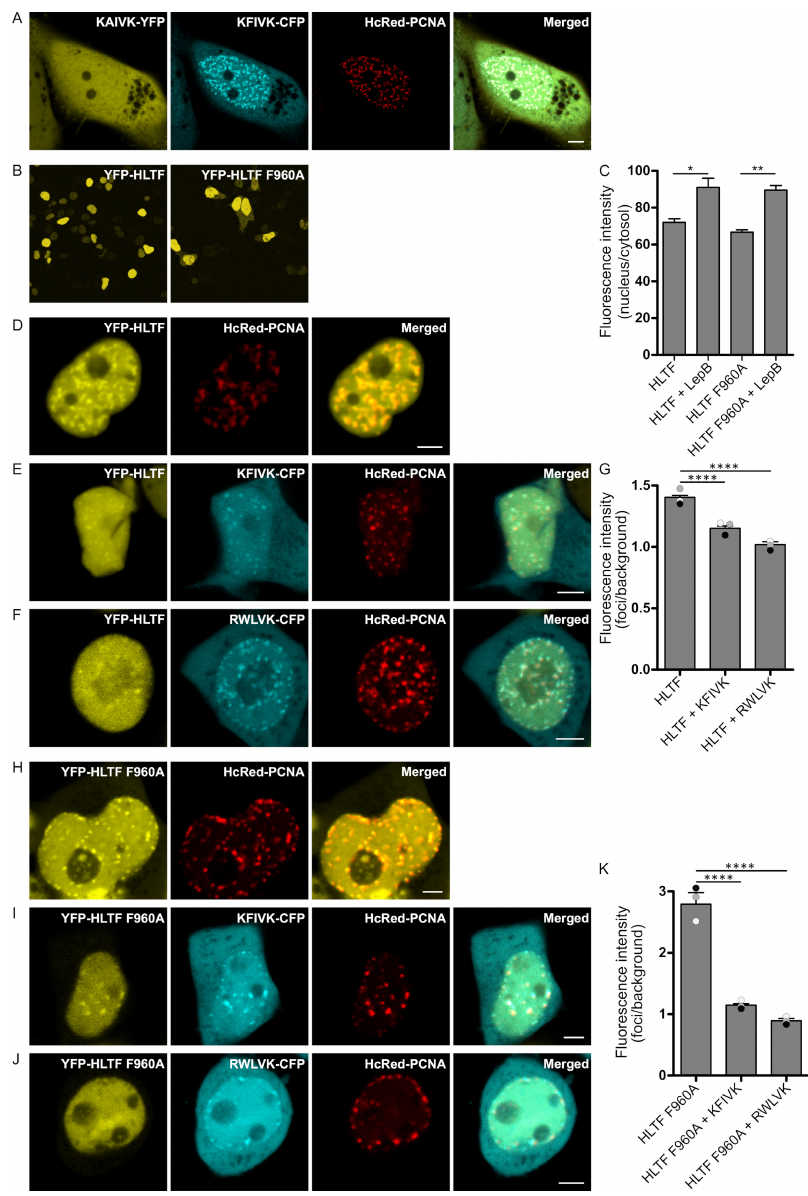
Figure 1. APIM in HLTF is a functional PCNA interacting motif. ( A ) Overexpressed KAIVK-YFP (mutAPIM in HLTF), KFIVK-CFP (APIM in HLTF), and HcRed-PCNA. ( B ) Overview of subcellular localization of YFP-HLTF and YFP-HLTF F960A, and ( C ) quantification of their nuclear localization in cells treated with Leptomycin B (LepB; 30 ng / mL, 45 min) ( n = > 90 cells per sample). ( D ) Overexpressed YFP-HLTF and HcRed-PCNA; ( E ) YFP-HLTF, KFIVK-CFP (APIM of HLTF) and HcRed-PCNA; and ( F ) YFP-HLTF, RWLVK-CFP, and HcRed-PCNA. ( G ) Quantification of YFP-HLTF foci intensities alone ( n (number of foci) = 132) and with co-transfection of KFIVK-CFP ( n = 76) or RWLVK-CFP ( n = 59) from three biological replica depicted in white, gray, and black dots. Bars represent averages. ( H ) Overexpressed YFP-HLTF F960A and HcRed-PCNA; ( I ) YFP-HLTF F960A, KFIVK-CFP (APIM of HLTF), and HcRed-PCNA; and ( J ) YFP-HLTF F960A, RWLVK-CFP, and HcRed-PCNA. ( K ) Quantification of YFP-HLTF F960A foci intensities alone ( n = 84) and with co-transfection of KFIVK-CFP ( n = 103) or RWLVK-CFP ( n = 98) from three biological replica depicted in white, gray, and black dots. Bars represent averages. Quantifications in G and K are based on at least 10 di ff erent images per confocal dish / sample in cells with similar protein expression. Foci intensity quantifications were done by using processing software Fiji (ImageJ). Two-sided Student’s t -test, * p < 0.05, ** p < 0.01, **** p < 0.0001. All images are from live cells. Scale bar = 5 µ